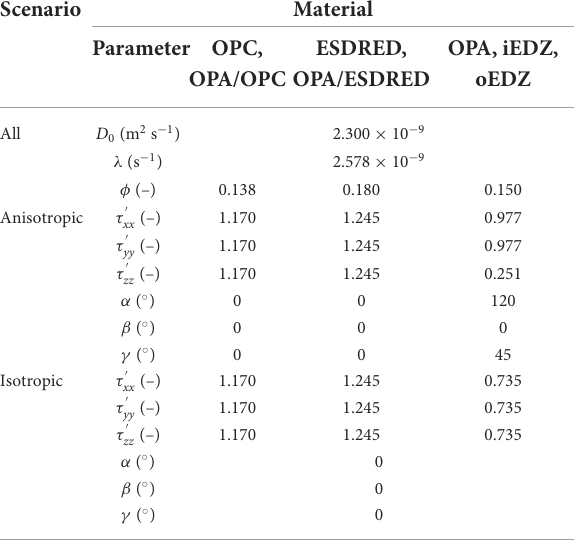
TABLE 3 Model parameters for simulation of Mont Terri CI-D in-situ diffusion experiment.